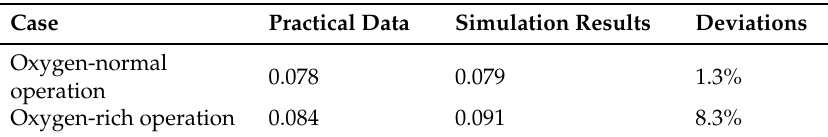
Table 2. Comparison of the measured and simulation results.